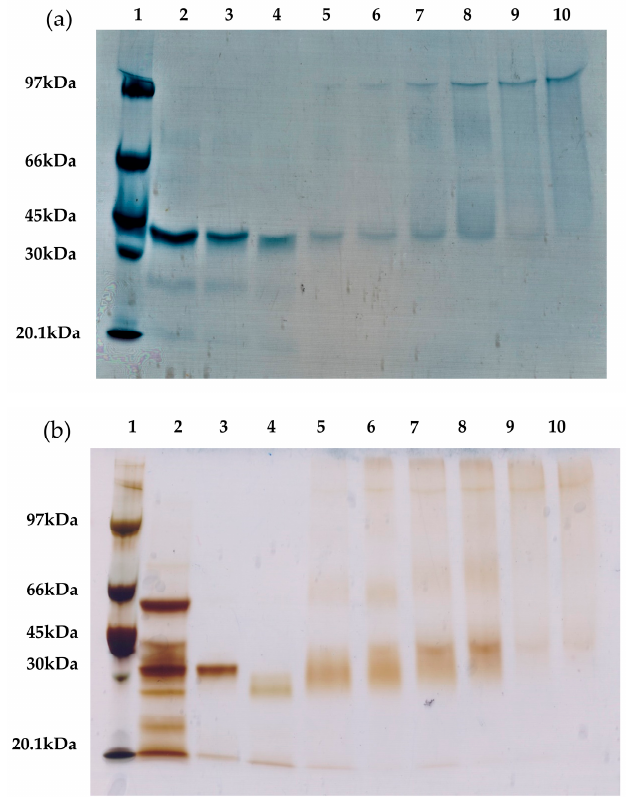
Figure 7. SDS-PAGE analysis of different lipase preparations of ( a ) TLL and ( b ) RML. Lanes: 1. Molecular weight markers; 2. soluble enzyme; 3. unmodified preparation; 4. aminated preparation; 5. cross-linked with 1.5 kDa Dx-CHO for 3 h; 6. cross-linked with 1.5 kDa Dx-CHO for 24 h; 7. cross-linked with 6 kDa Dx-CHO for 3 h; 8. cross-linked with 6 kDa Dx-CHO for 24 h; 9. cross-linked with 25 kDa Dx-CHO for 3 h; and 10. cross-linked with 25 kDa Dx-CHO for 24 h. ( a ) TLL: the soluble enzyme concentration was 0.35 mg/mL, and all the conjugates presented a concentration of 2 mg/g; ( b ) RML: the soluble enzyme concentration was 0.875 mg/mL, and all the conjugates presented a concentration of 5 mg/g.